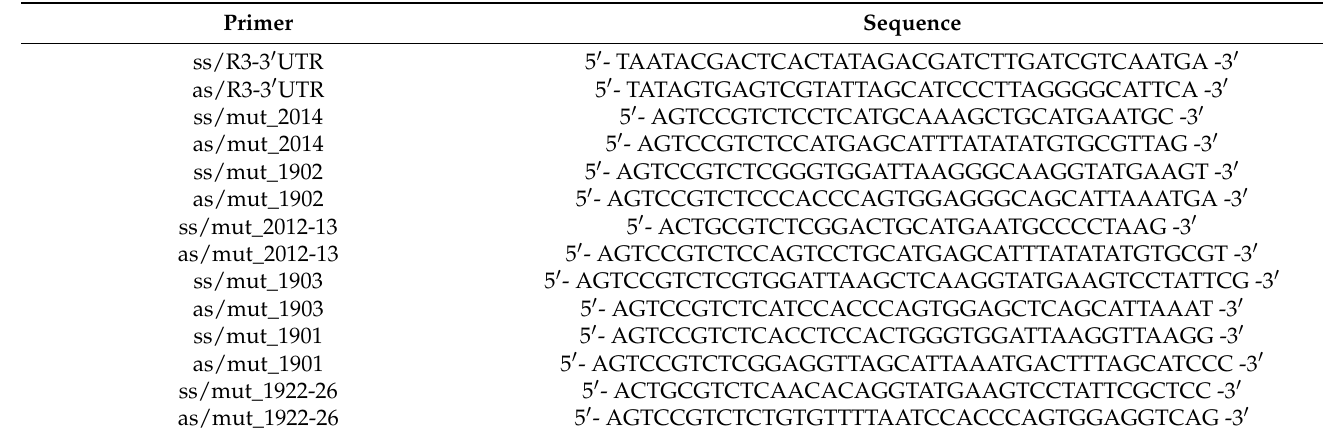
Table A1. Primers used in this study.